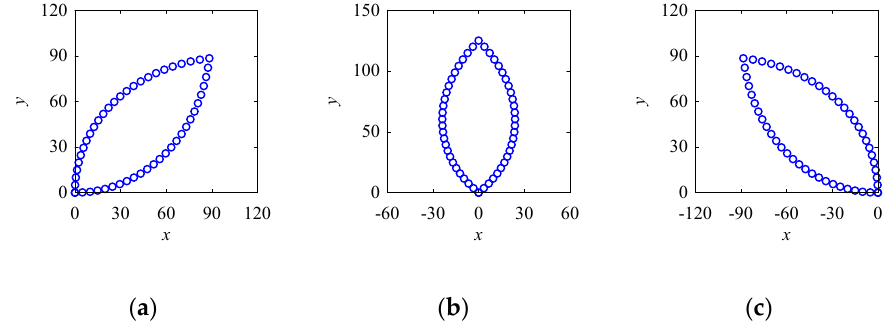
Figure 10. Role of an Initial Angle. ( a ) When ϕ = 0 ◦ ; ( b ) when ϕ = 45 ◦ ; ( c ) when ϕ = 90 ◦ . Table 1. Summary of the characteristics of the point-cloud-creation algorithm.